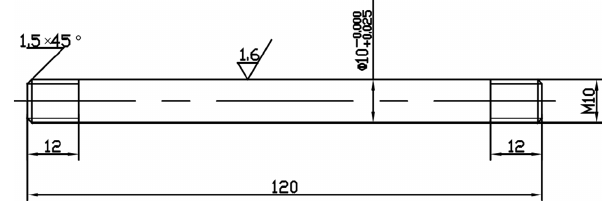
Figure 1: Working diagram of the high-temperature tensile specimens.